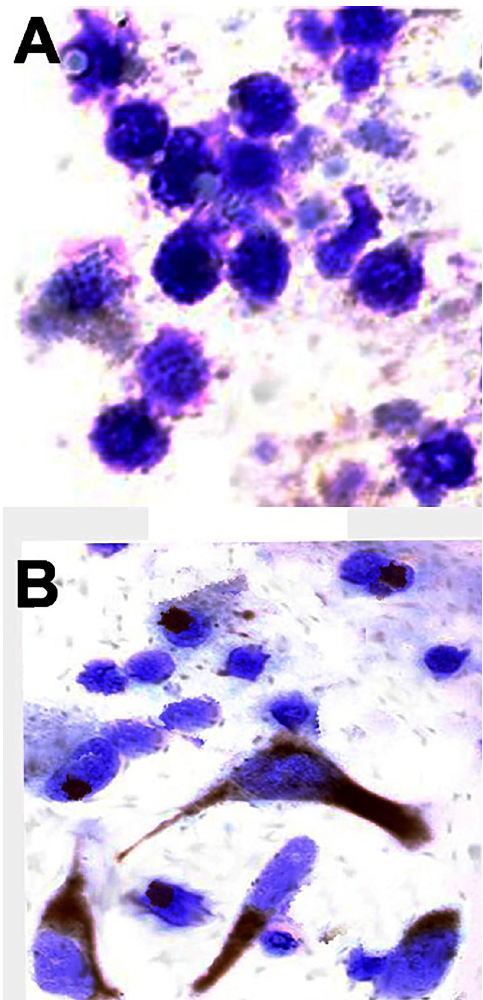
Fig 4. Expression of IFN- γ R by embryonic brain astrocytes. IFN- γ R was detected by immunohistochemistry. Counter staining was conducted with haematoxylin. As depicted in the micrograph, E7 astrocytes did not express receptors for IFN- γ (Fig 4A), while E21 astrocytes showed strong expression of IFN- γ R (Fig 4B). Pictures were acquired with light microscopy (x630). The micrograph is a representation of several fields scanned in each chamber. All fields showed expression of IFN- γ R on E21, but not